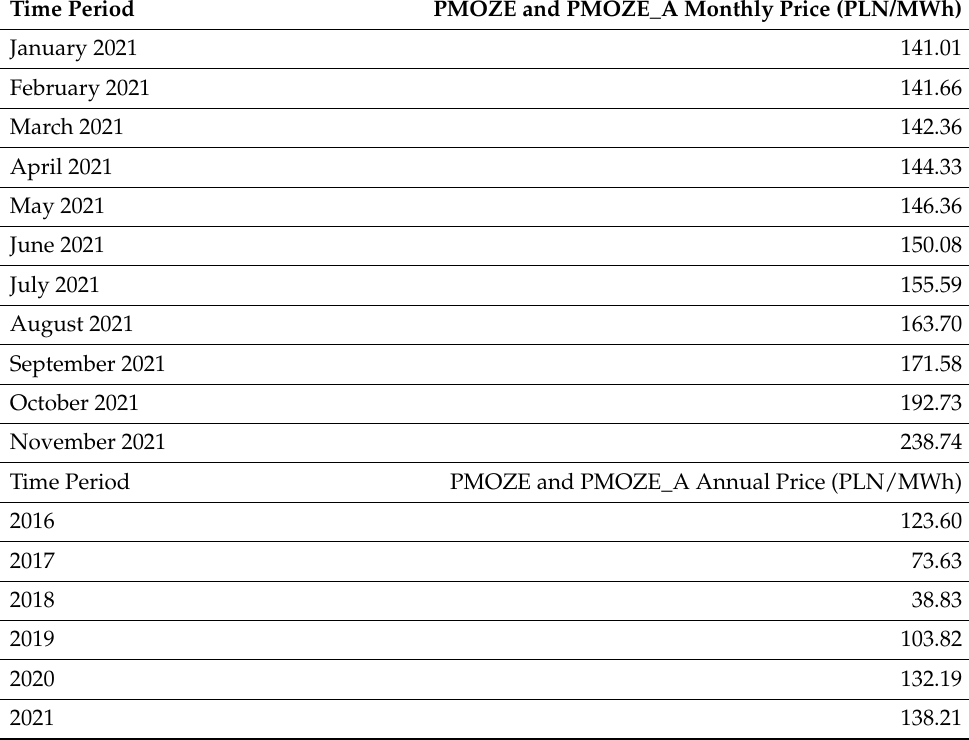
Table 2. Monthly and annual average price of property rights pursuant to Article 47(8)(2) of the Renewable Energy Sources